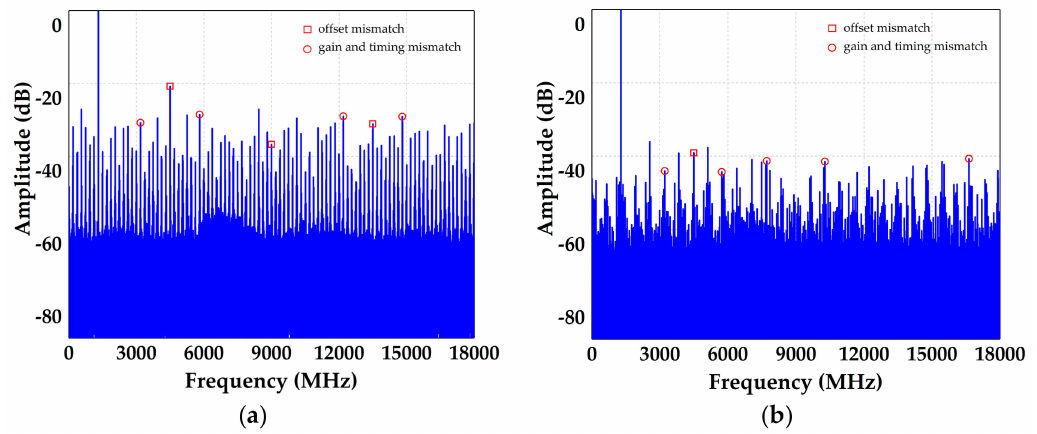
Figure 17. Measured output spectrum when fin = 1.2 GHz ( a ) before calibration and ( b ) after calibration When the input signal frequency is 8.1 GHz, the frequency spectrum is shown in Figure 18a. The SNDR of the output signal is 21.24 dB and the SFDR is 29.12 dB. When the input frequency is 17.1 GHz, the frequency spectrum is shown in Figure 18b. The SNDR of the output signal obtained from measurement is 18.6 dB, and the SFDR is 24.50 dB. The spurs produced by the mismatch of the gain and timing mismatch become the main spurious components. The higher the input frequency, the greater the impact of the timing mismatch on the output linearity.